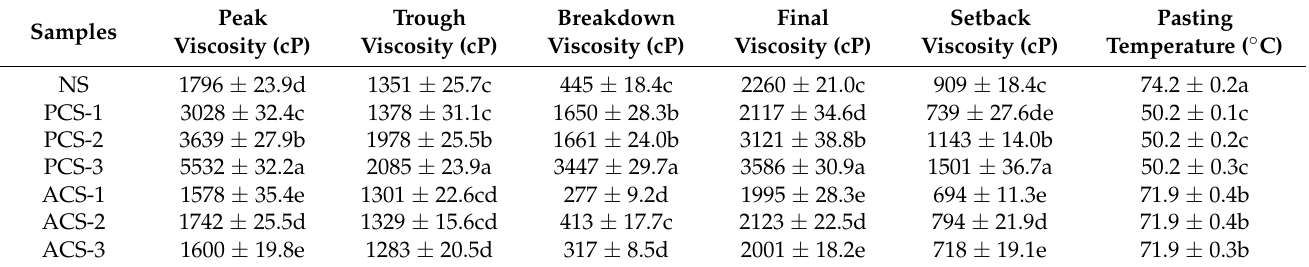
Table 4. Pasting properties of native, phosphorylated and acetylated chestnut